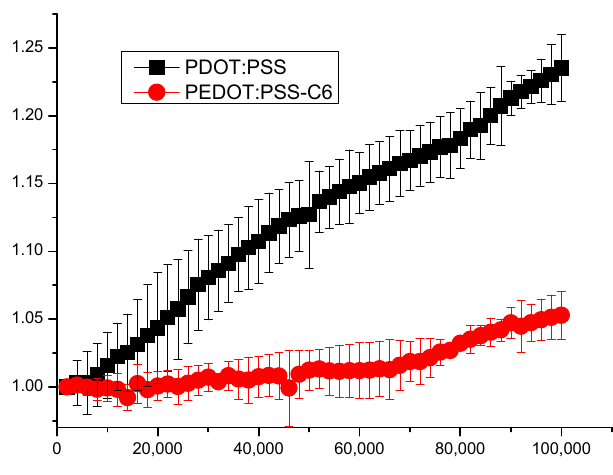
Figure 8. Surface resistance ratio (R/Ro) of PEDOT:PSS films as a function of bending cycles at a curvature radius of 3 mm.